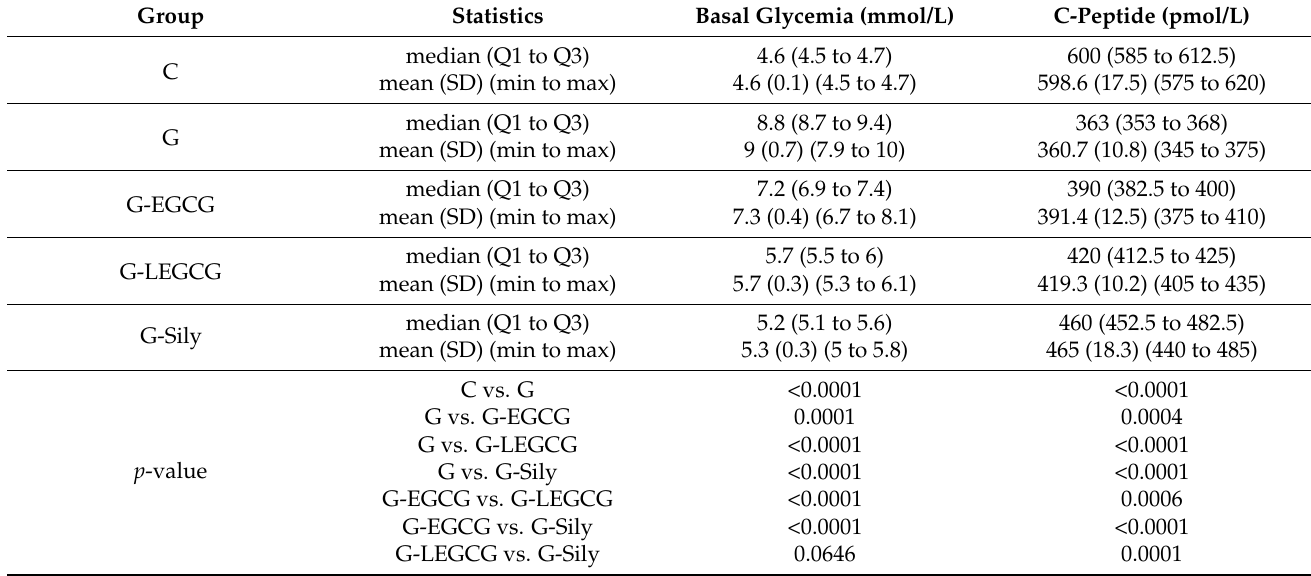
Table 3. Impairment of pancreatic function induced by gentamicin by groups. The comparative effect of EGCG, LEGCG, and